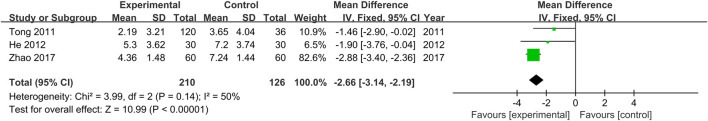
Forest plot for the meta-analysis of Chinese medical syndrome scores.